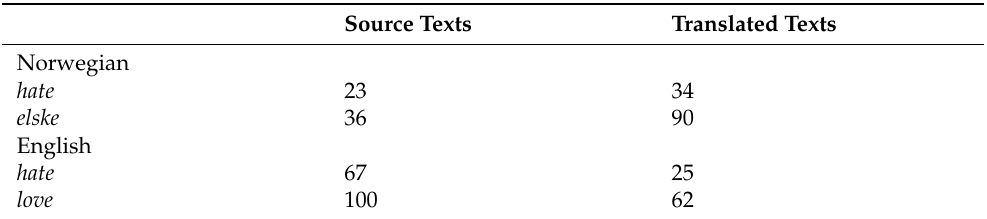
Table 2. (Absolute) frequencies of ‘hate’ and ‘love’ verbs in Norwegian and English translated and untranslated